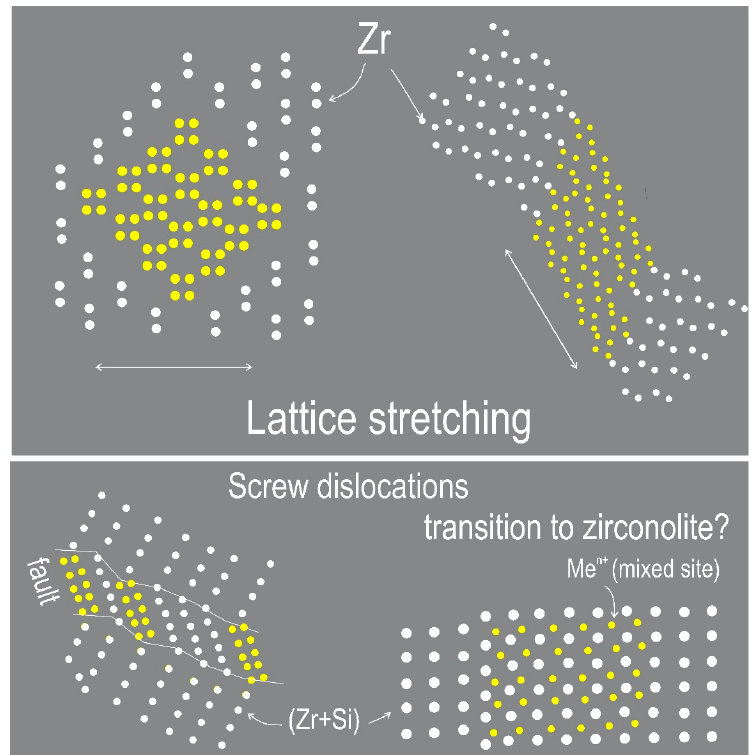
Figure 16. Schematic representation of atom arrangements in defects indicating lattice stretching and screw dislocations leading to expansion of the zircon structure. Such aspects are attributable to self-induced irradiation damage effects.